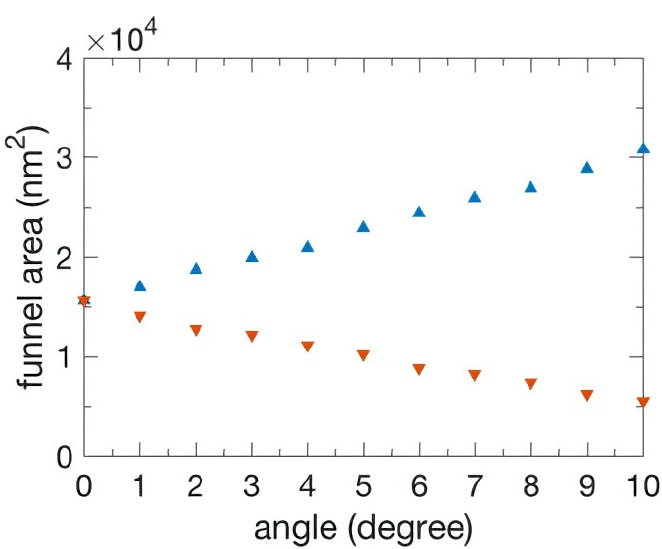
Figure 1. The time-averaged Poynting vector fields of light energy funneling at incident angle ( a ) 0 ◦ , ( b ) 5 ◦ , and ( c ) 10 ◦ into subwavelength grooves etched in a perfect electric conductor.